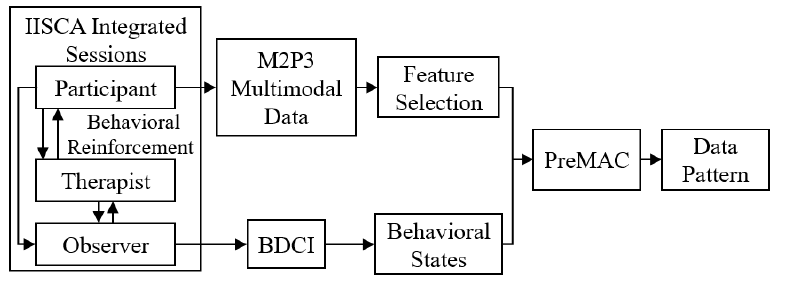
Figure 1. Study flow chart.